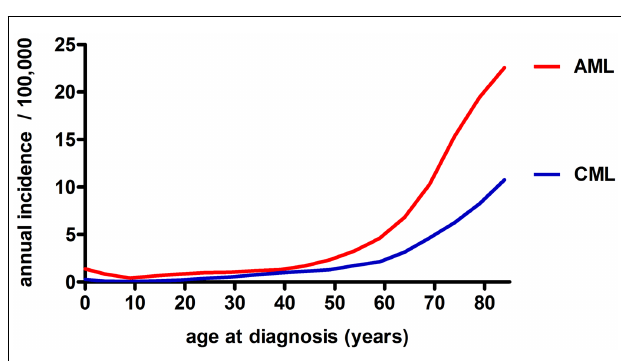
FIGURE 2 |Annual incidence ofAML and CML in the USA among different age groups (both sexes, all race groups, years 1992–2010), based on data from the NCI/SEER (11)